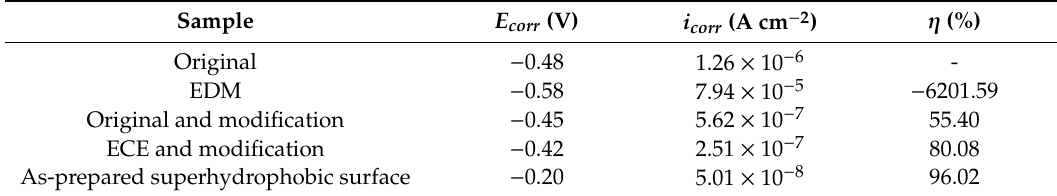
Figure 9. Corrosion resistance of the original titanium surface, EDM surface, original and modification, ECE and modification surface, and the as-prepared superhydrophobic surface in neutral solution (3.5 wt% NaCl) for 30 min. ( a ) Tafel curves, ( b ) Nyquist plots, ( c ) Enlarged scope of ( b ) Nyquist plots in the high frequency range, ( d ) Bode plots. Table 1. Details of Tafel polarization curves of titanium samples at different processes in the neutral solution (3.5 wt% NaCl).